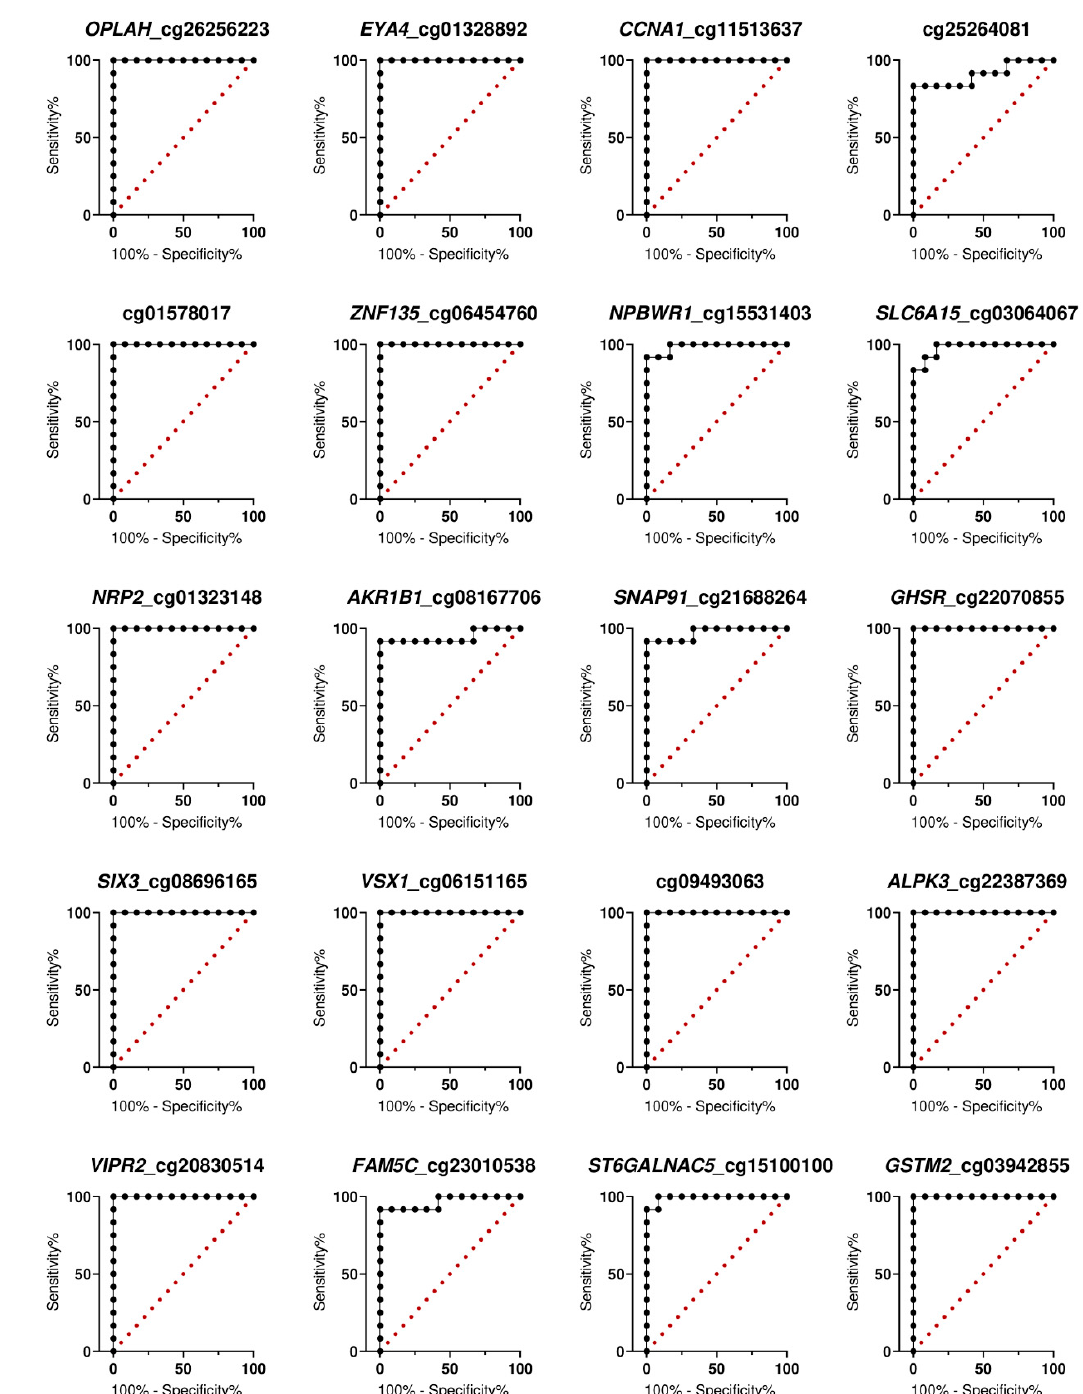
Figure 4. ROC curve-based evaluation of the diagnostic accuracy of hypermethylated open chromatin methylation markers.